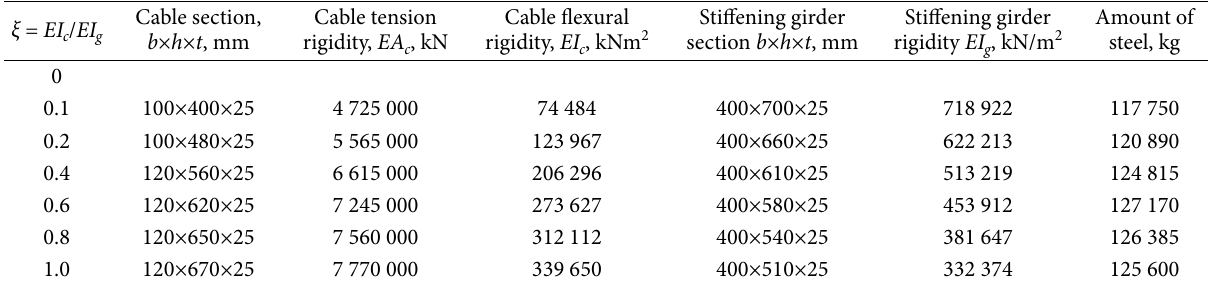
Table 1. Geometric characteristics of cable and stiffening girder Cable section, ξ = EI c / EI g b × h × t ,